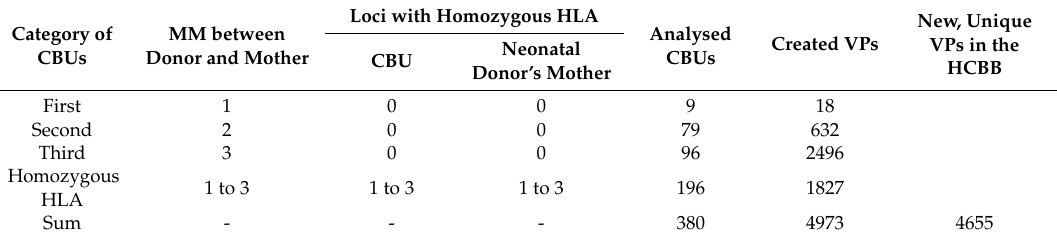
Table 2. Summary of the number of the VPs that was created for each category of CBUs, depending on the mismatch (MM) between the CBU and the neonatal donor’s